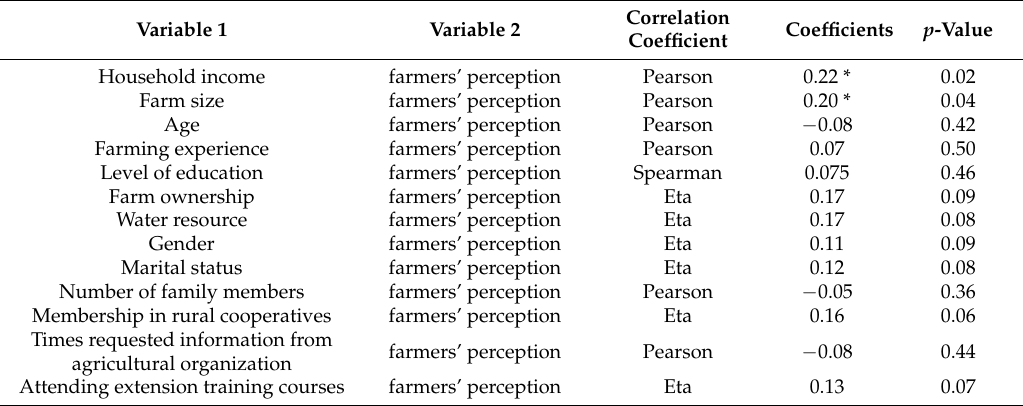
Table 6. Bivariate analysis (Pearson, Spearman, and Eta correlation